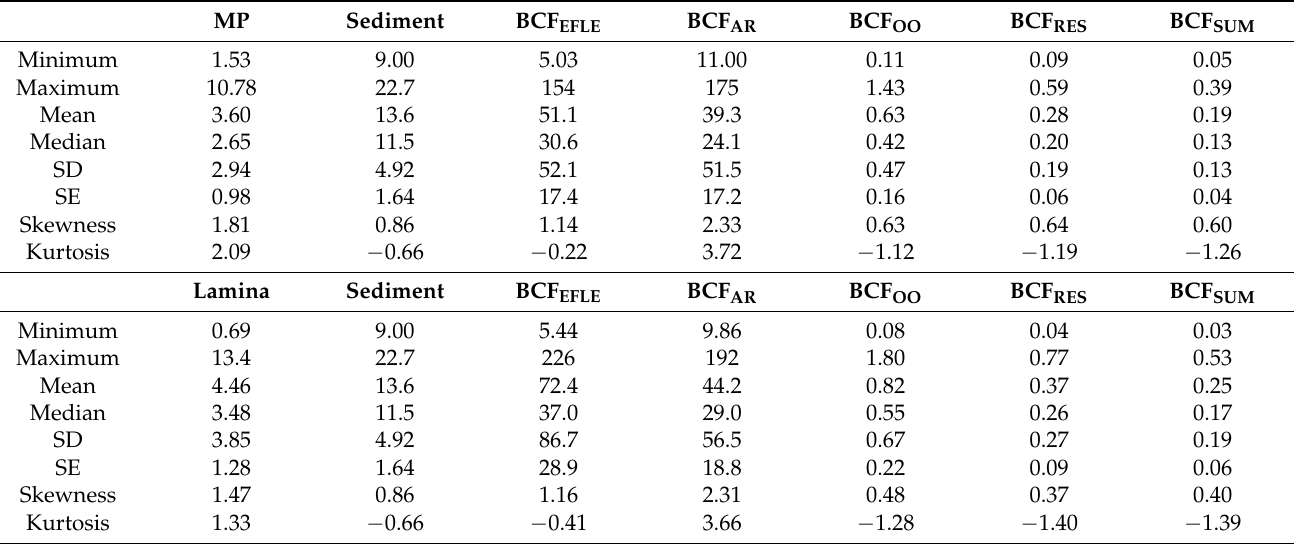
Table 7. Overall statistics of Cu concentrations (mg/kg dry weight) in the midrib plus petiole (MP) and lamina of Rhizophora apiculata , with their habitat geochemical fractions of sediments and their bioconcentration factors (BCF) values, collected from nine sampling sites in the mangrove areas of Sepang and Lukut. N =